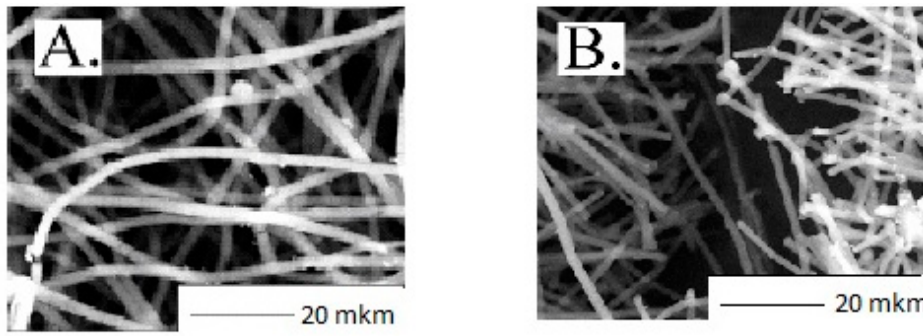
Figure 3. Microphotographs of the non-woven materials based on PHB: ( A ) before and ( B ) after 21 days of hydrolysis in the phosphate buffer solution.